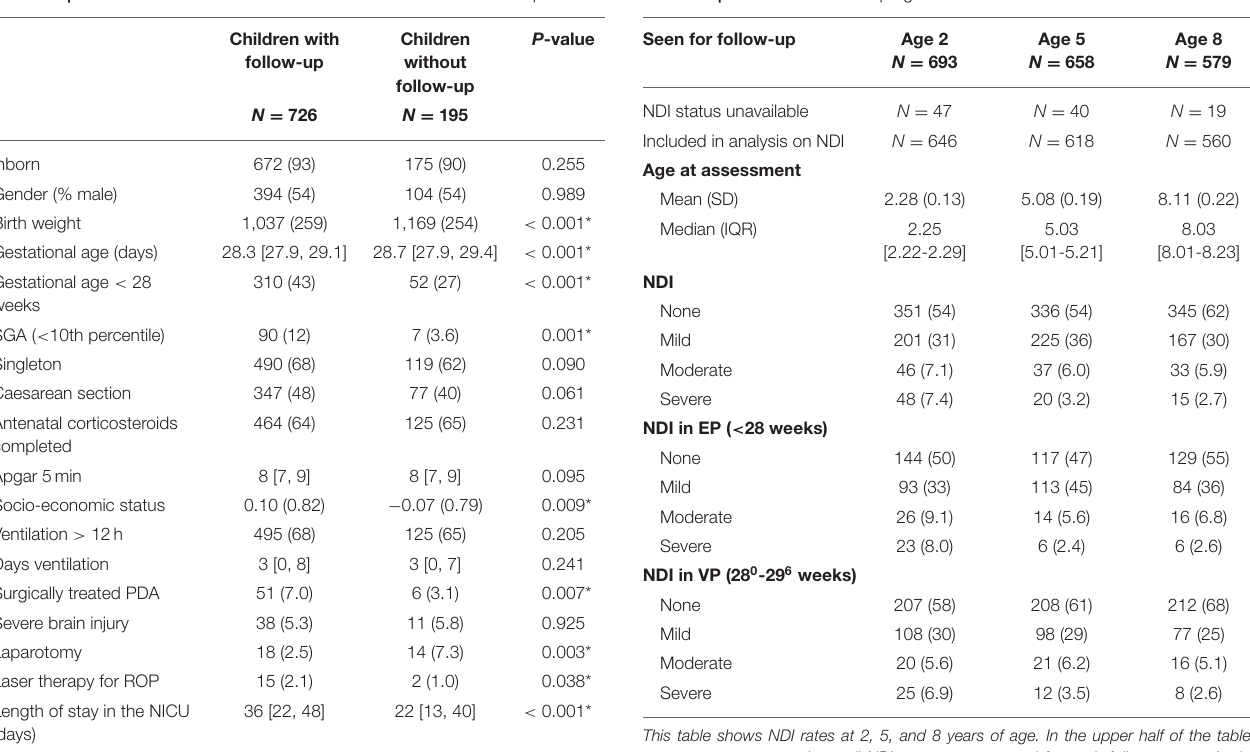
TABLE 3 | Baseline characteristics for children with and without follow-up. TABLE 4 | NDI at each follow-up